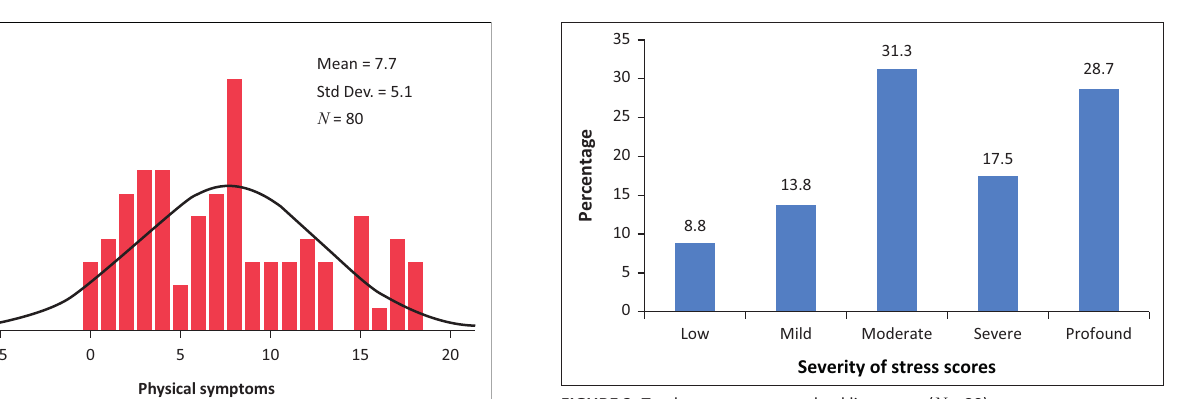
FIGURE 3: Total stress symptom checklist scores ( N = 80).